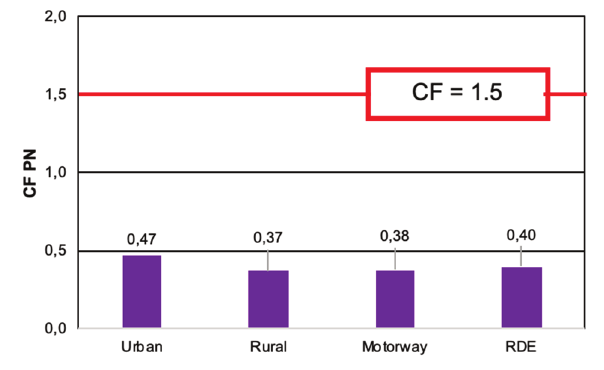
Fig. 14. PN emissions in respective phases of RDE cycle and average PN emissions On Fig. 15 are given a comparison between the results cle in respective driving cycles.